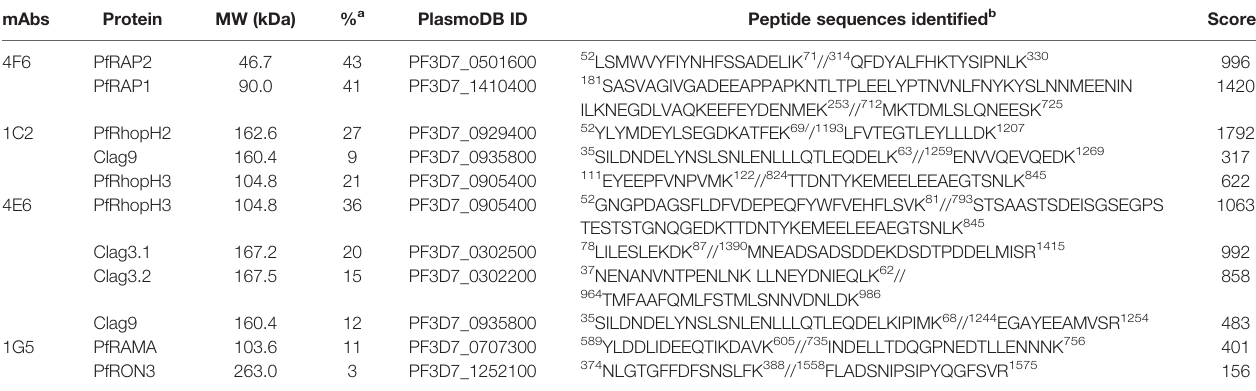
TABLE 1 | LC-MS/MS analysis of immunoaf fi nity-puri fi ed proteins with each monoclonal antibody from Plasmodium falciparum schizont lysates.